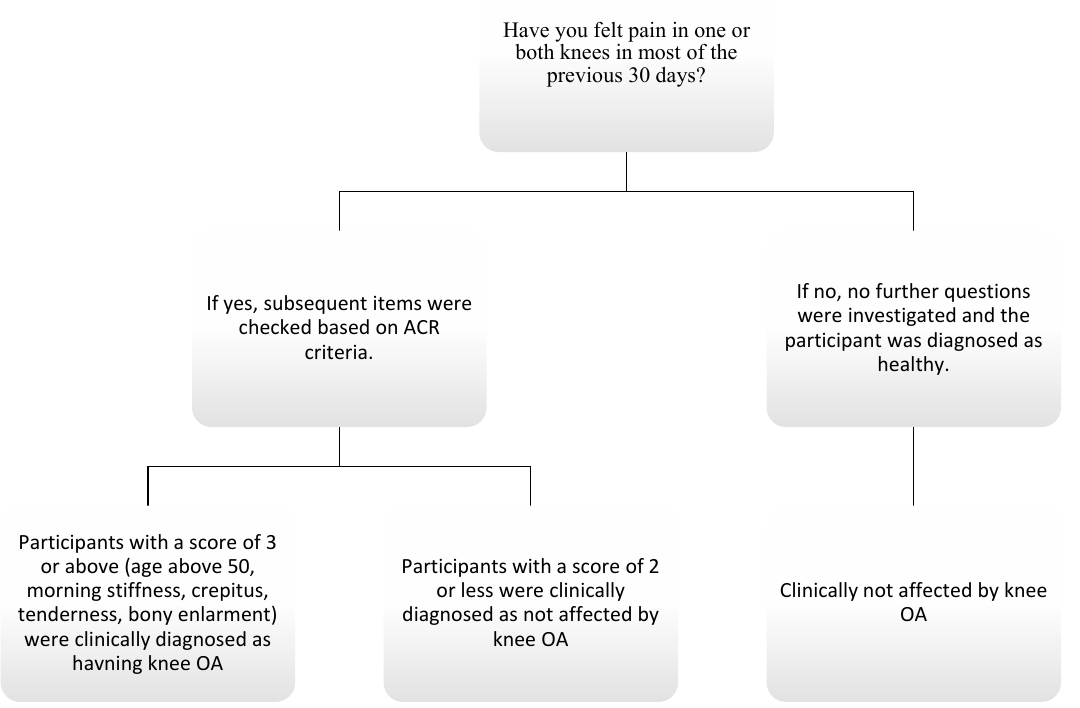
Figure 1. Flow diagram of knee OA diagnosis based on ACR criteria.